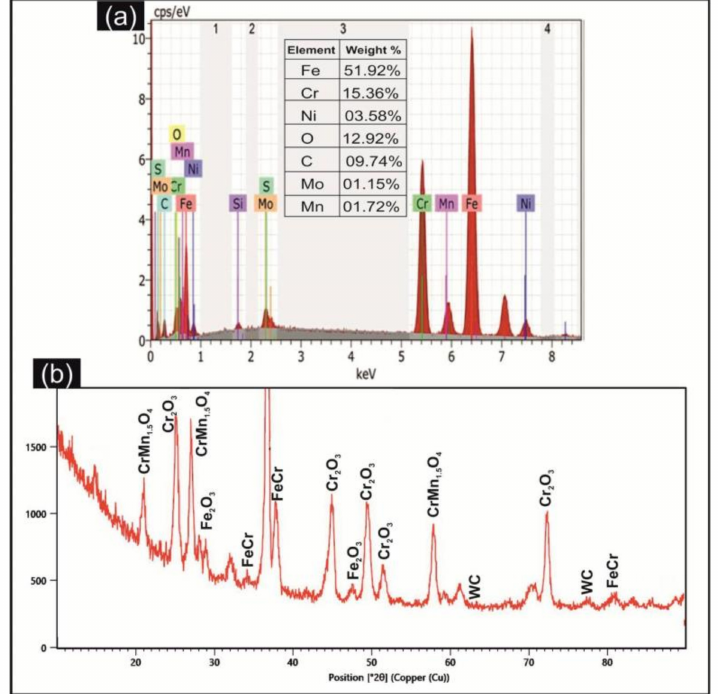
Figure 5. ( a ) EDS elemental spectrum and ( b ) XRD pattern of EDMed substrate.